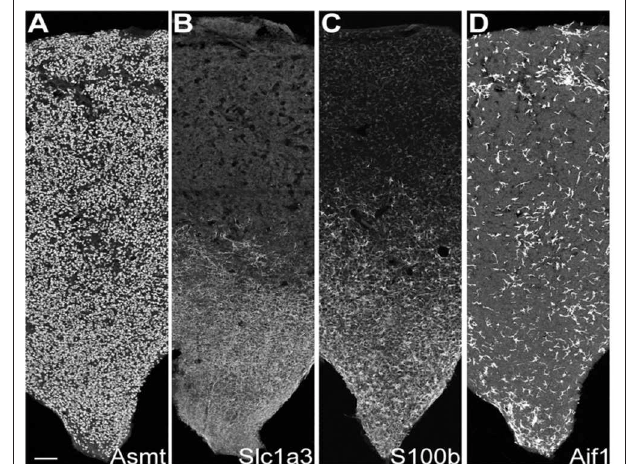
FIGURE 2 | Transcriptomic characterization of cell types in the daytime rat pineal gland. (A) t-Distributed stochastic neighbor embedding (t-SNE) visualization of over 5,000 daytime rat pineal gland cells as profiled by scRNA-seq. Cell types are color-coded by cluster. (B) Hierarchical clustering dendrogram showing cell type transcriptomic similarity, including two pinealocyte subtypes, the three astrocyte subtypes, the two microglia subtypes, and two vascular-associated cell types: VLMCs and endothelial cells. (C) Violin plots of marker genes for cells from each cell type. Y-Axis is natural log of normalized counts. Reproduced from Mays et al. (43). This figure and associated legend is published with permission of the original publisher under license CC0.1.0.